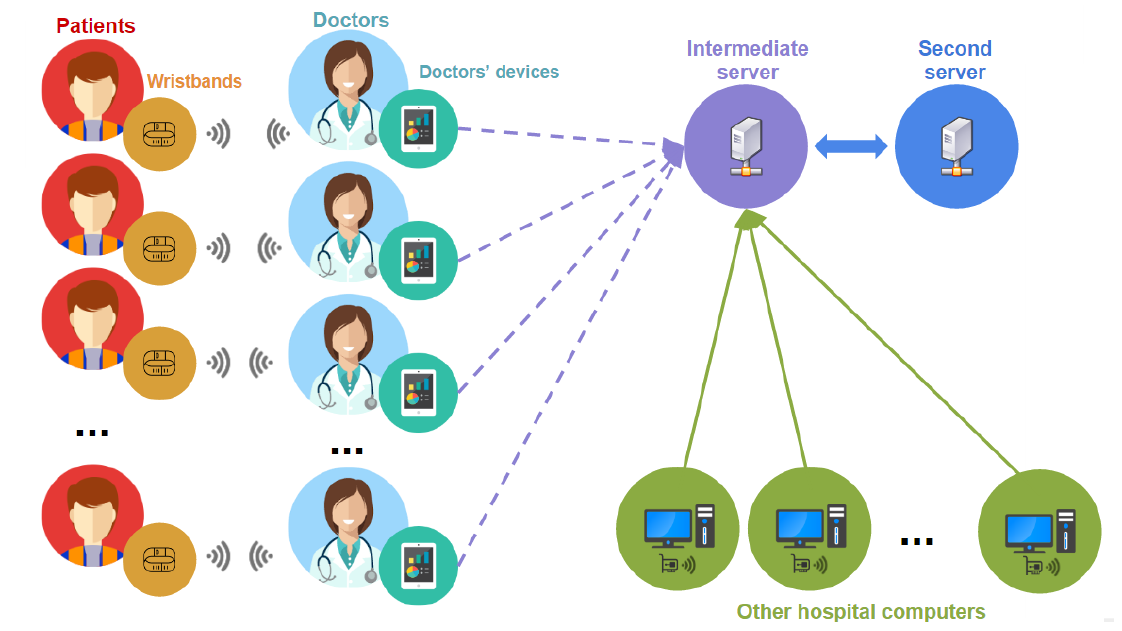
Figure 3. System’s communication